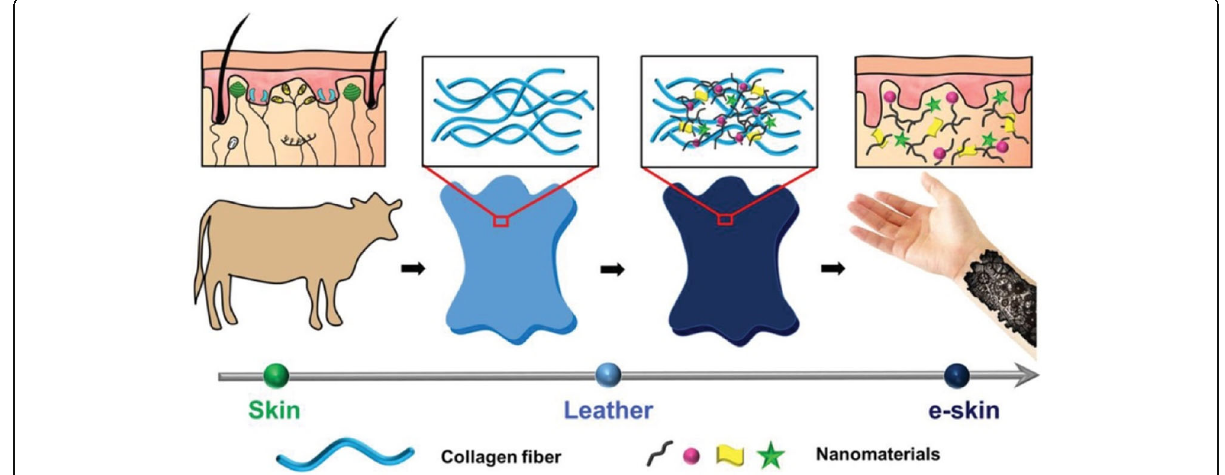
Fig. 9 Schematic of design principle of leather based electronic skins [84], Copyright (2018), with permission from